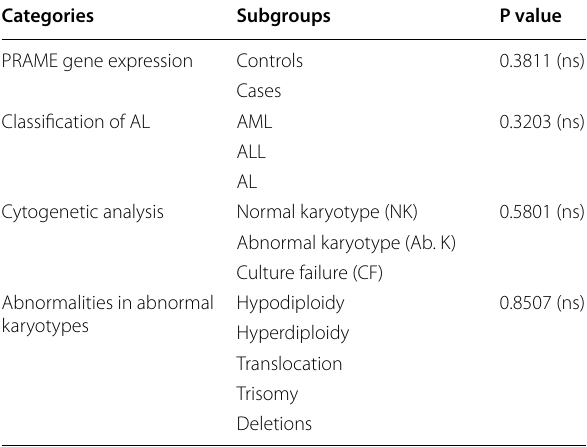
Table 2 PRAME gene expression in acute leukemia patients Categories